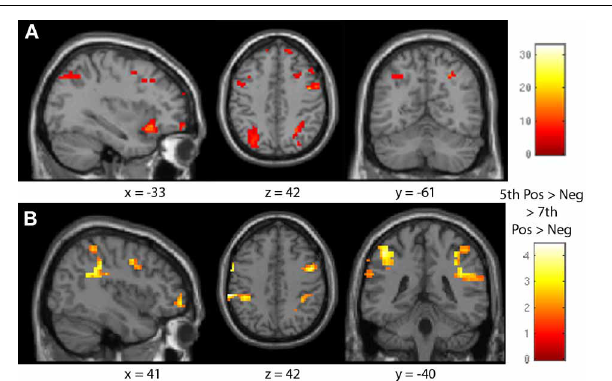
FIGURE 8 | Age by sign neural distance effect interaction. (A) The bilateral intraparietal sulcus and parts of the inferior and middle frontal gyri were sensitive to the interaction of age group and comparison sign distance effects. (B) Fifth-graders showed a greater difference between positive and negative number distance effects in the bilateral IPS and bilateral inferior frontal gyrus than did